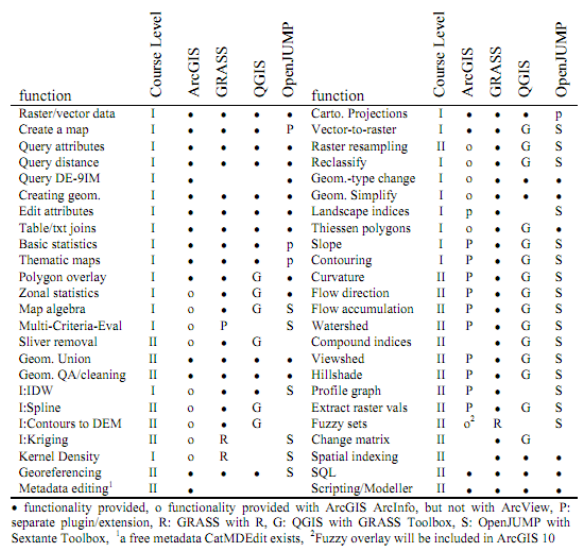
Table 1. Software functionality evaluation for teaching Introduction to GIS (I) & Advanced GIS (II), adopted from (Steiniger & Hunter,